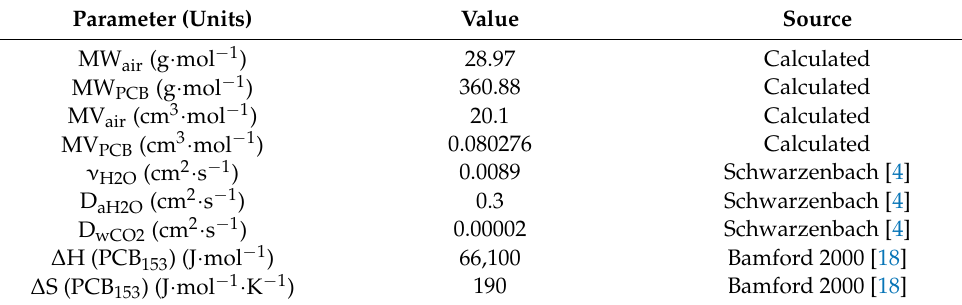
Table 3. Parameters, used in calculations of air–water exchange. Parameter (Units) Value Source